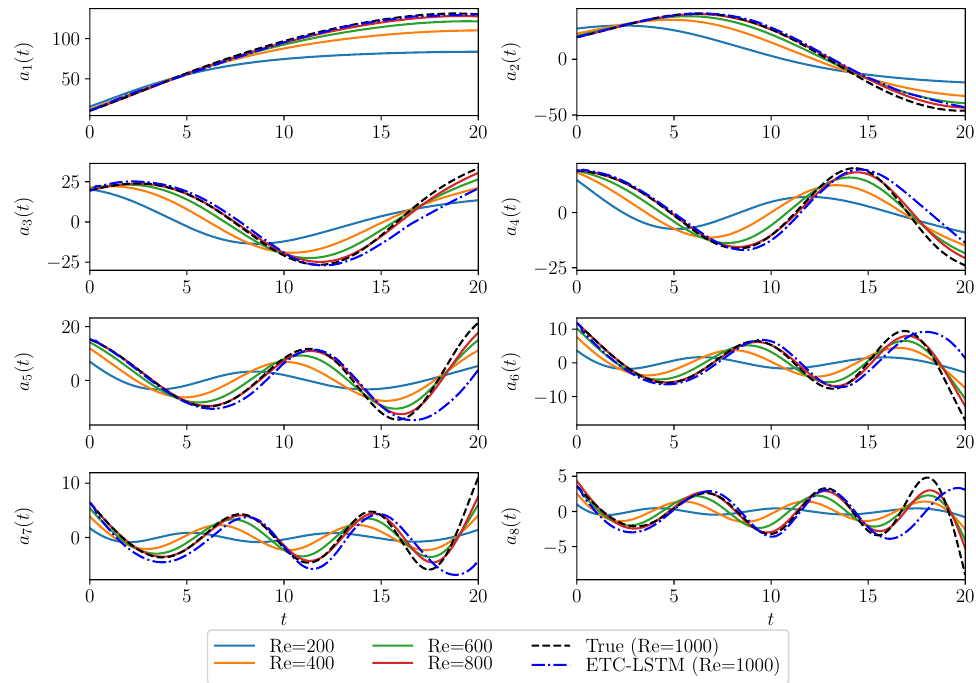
Figure 11. Evolution of vorticity modal coefficients at different training Reynolds numbers and the test Reynolds number (Re = 1000) with γ = 0.1. The time series for Re = [ 200,400,600,800 ] are true vorticity modal